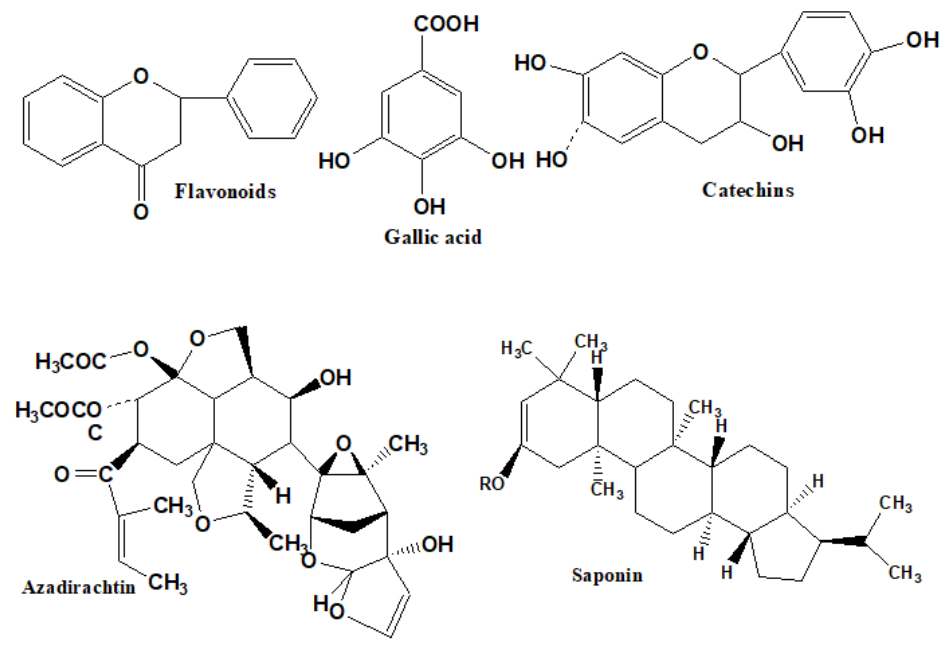
Figure 3. Portrait of the phytochemicals present in A. indica and M. indica tree leaves using ChemDraw Ultra 8.0 software.